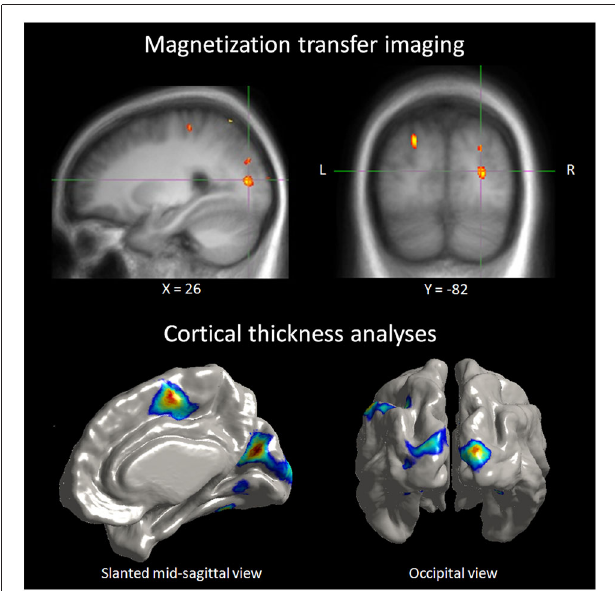
FIGURE 3 | Correlation between neuroanatomical and behavioral measures in blind individuals . Top panel: illustration depicting a right extrastriate visual area where the MT ratio (an indirect measure of myelin content) in blind individuals was found to be predictive of behavioral performance in a pitch discrimination task. Bottom panel: illustration depicting occipital regions where cortical thickness in blind individuals was positively correlated to the same performance measures of the pitch discrimination (Voss and Zatorre, 2012).